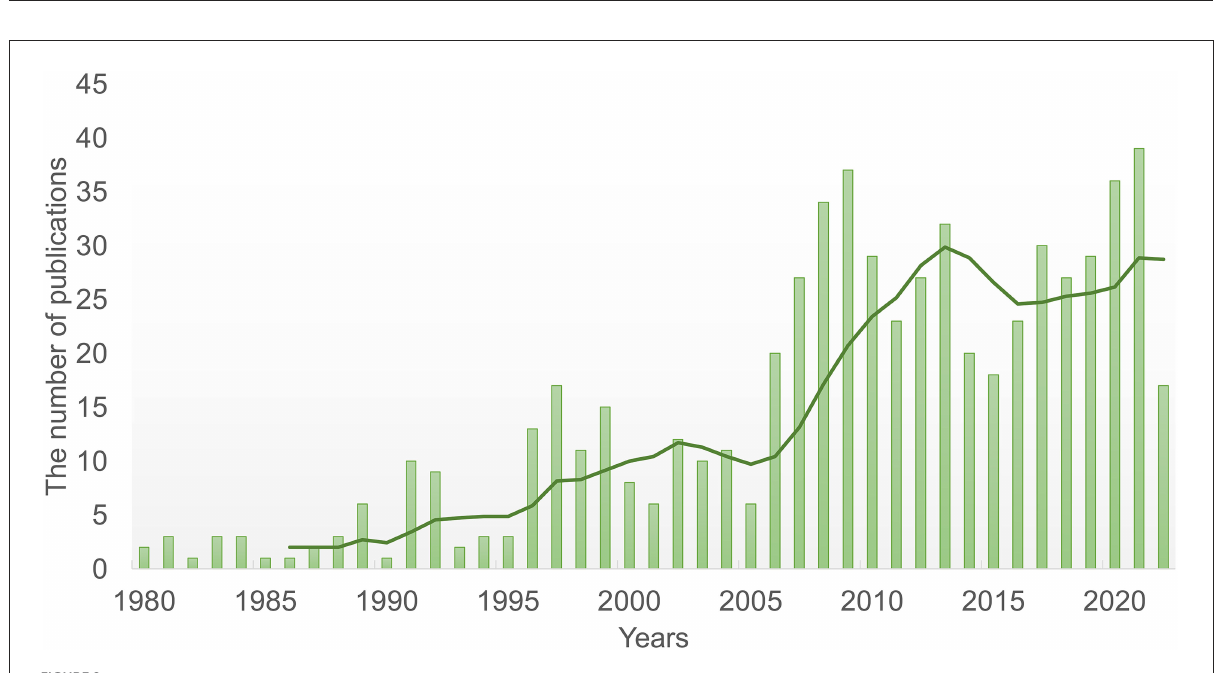
FIGURE9 Trends of the myocardial bridge published over the past 43 years.